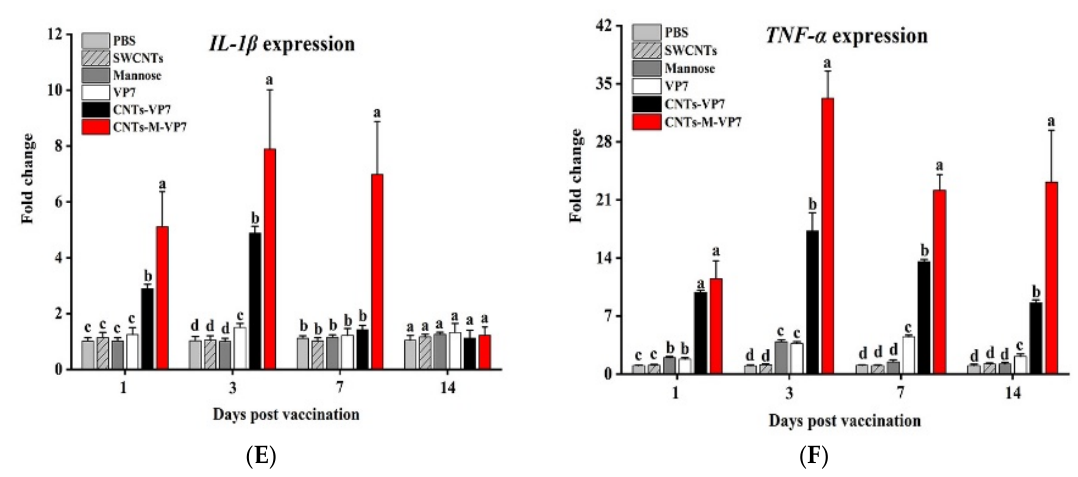
Figure 4. Expressions of ( A ) MHC -I, ( B ) CD8 , ( C ) MHC -II, ( D ) CD4 , ( E ) IL-1 β , and ( F ) TNF- α in vaccinated fish. Data are means for three assays and represented as mean ± SD. p values were calculated by Duncan’s test. Data at the same sampling time with different letters (a, b, c, and d) are significantly different ( p < 0.05).